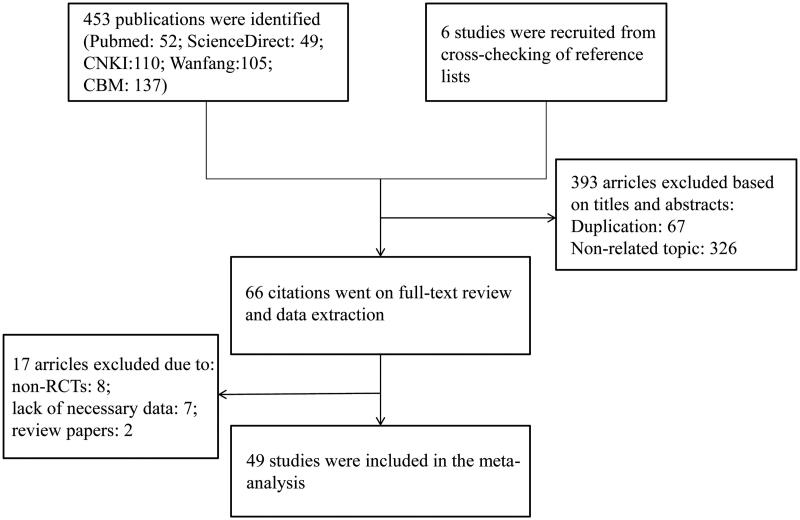
Flow diagram of literature search and selection.